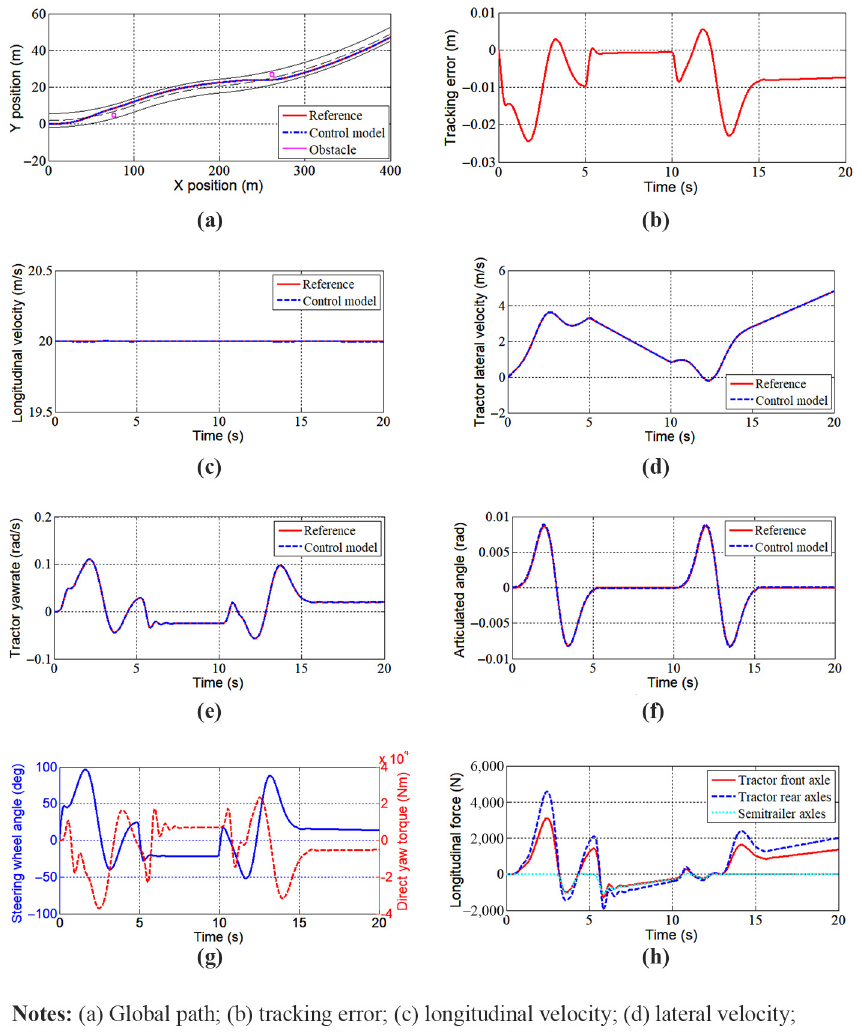
Figure 11 Control effects of speci fi c modes for anti-collision on a curved road